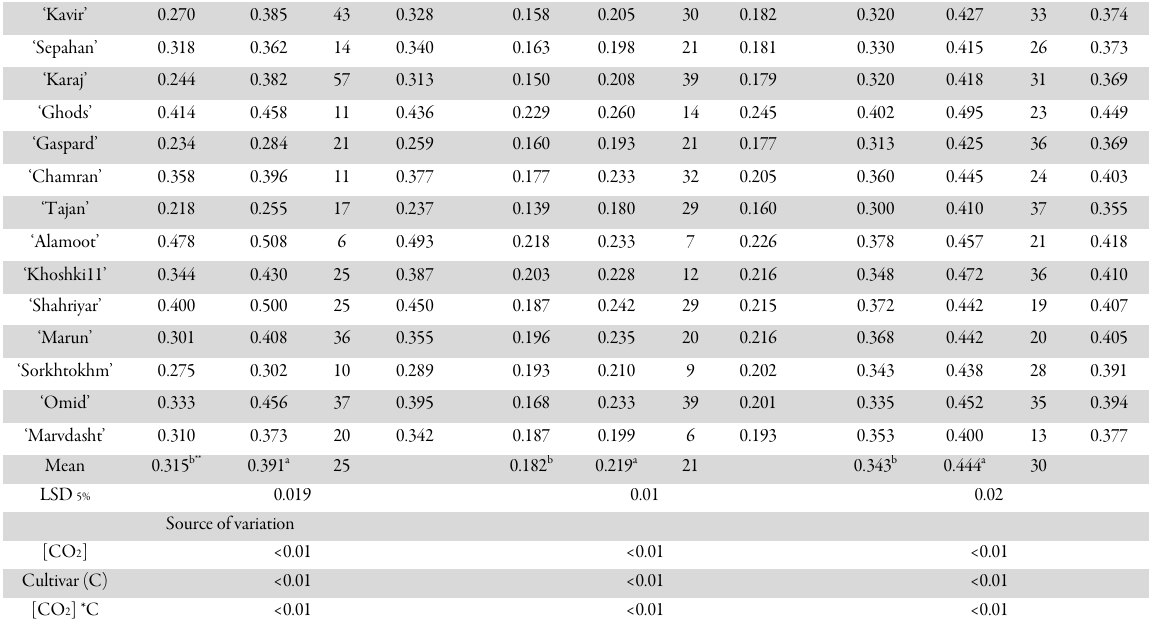
Table 4. Effects of two [CO 2 ] (380 ± 50 vs. 700 ± 50 µmol mol -1 ) on leaf area (cm 2 plant -1 ), plant height (cm) and root volume (cm 3 plant -1 ) of 20 Iranian bread wheat cultivars